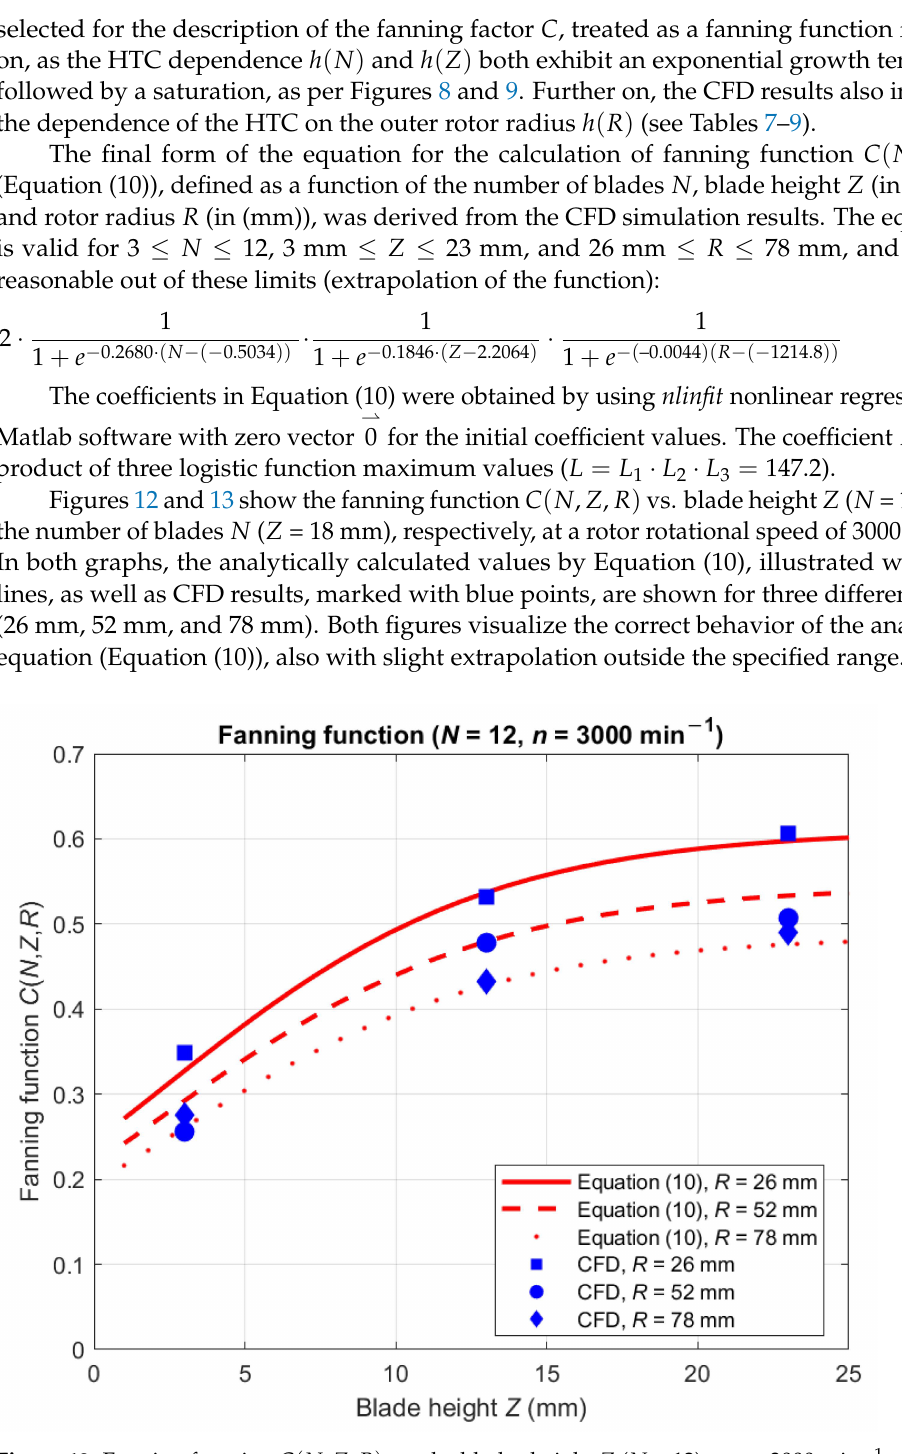
Figure 12. Fanning function C ( N , Z , R ) vs. the blades height Z ( N = 12) at n = 3000 min − 1